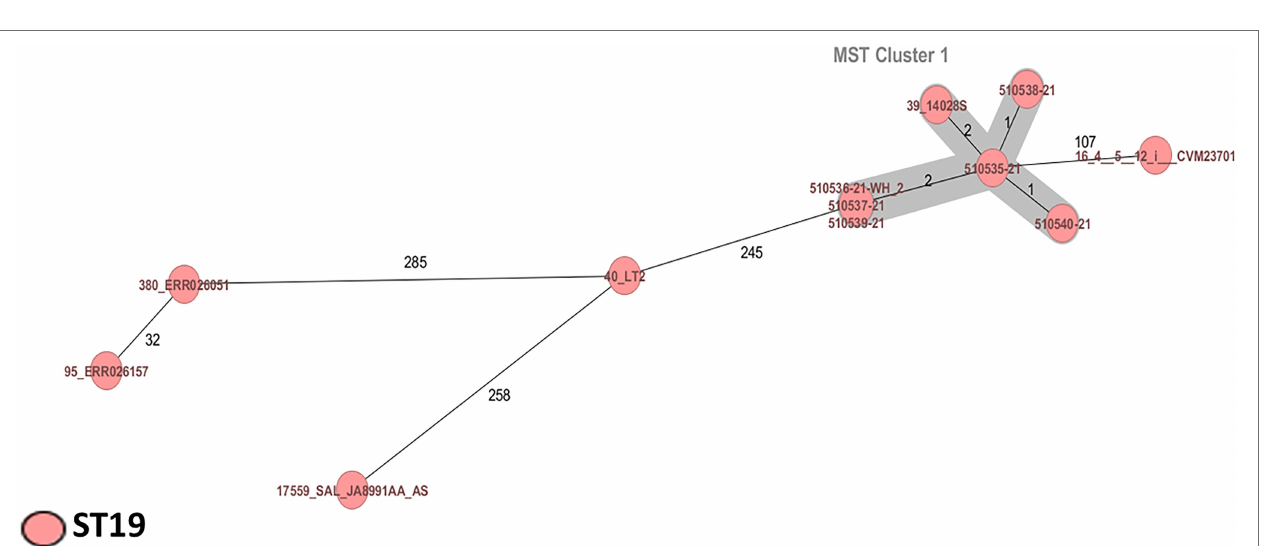
FIGURE 1 | Minimum spanning tree (MST) of five strains of Cronobacter sakazakii and one of Cronobacter malonaticus from powdered infant formula manufactured in Chile, complemented with strains of C. sakazakii and C. malonaticus ST1, ST31, and ST60 of clinical and food origin. Calculation of the MST was based on the defined cgMLST scheme comprising 3,678 target genes for C. sakazakii and C. malonaticus. Isolates are represented as colored circles according to the classical MLST. Black numbers according to the allelic differences between isolates. Isolates with closely related genotypes are marked as Cluster .